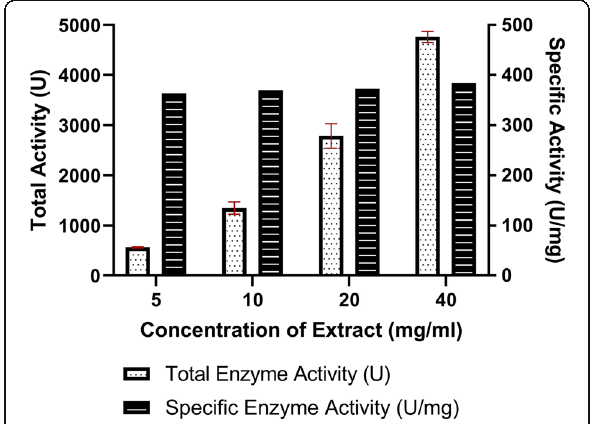
Fig. 2 Total enzyme activity and specific enzyme activity exhibited by Cinnamomum cappara leaf